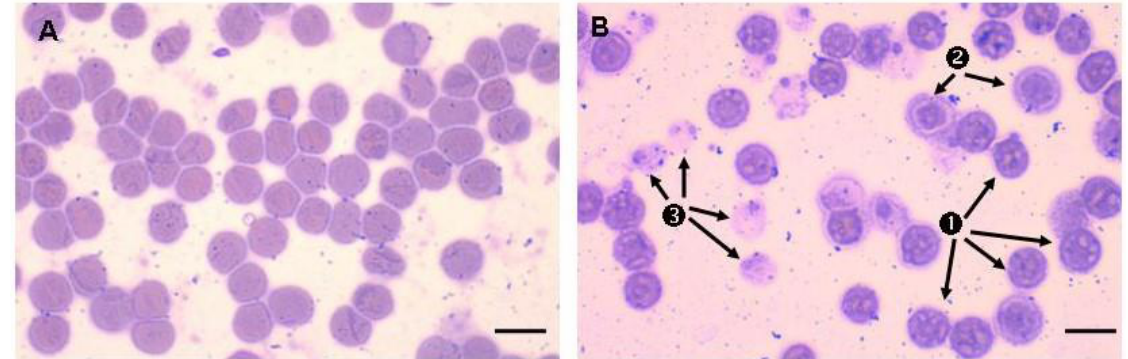
Figure 10. Glycation induces senescence and haemolysis of erythrocytes . Erythrocyte smears stained with May-Grünwald Giemsa stain for ( A ) normal erythrocytes. There is no porous structure in haemoglobin repartition in non-glycated erythrocytes. ( B ) Glycated erythrocytes incubated with 50 mM of glucose for 5 days at 37 °C display different morphologies. Arrows 1 feature erythrocytes with non-homogeneous structure and repartition of haemoglobin with presence of vacuoles. Arrows 2 feature erythrocytes with more condensed haemoglobin and a peripheral clear area. Arrows 3 feature erythrocyte ghosts corresponding to senescent RBCs after the release of haemoglobin following haemolysis. Bars indicate 10 μm.